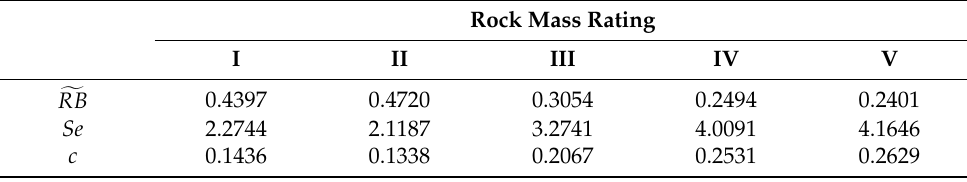
Table 4. Fusion process of the model validation.